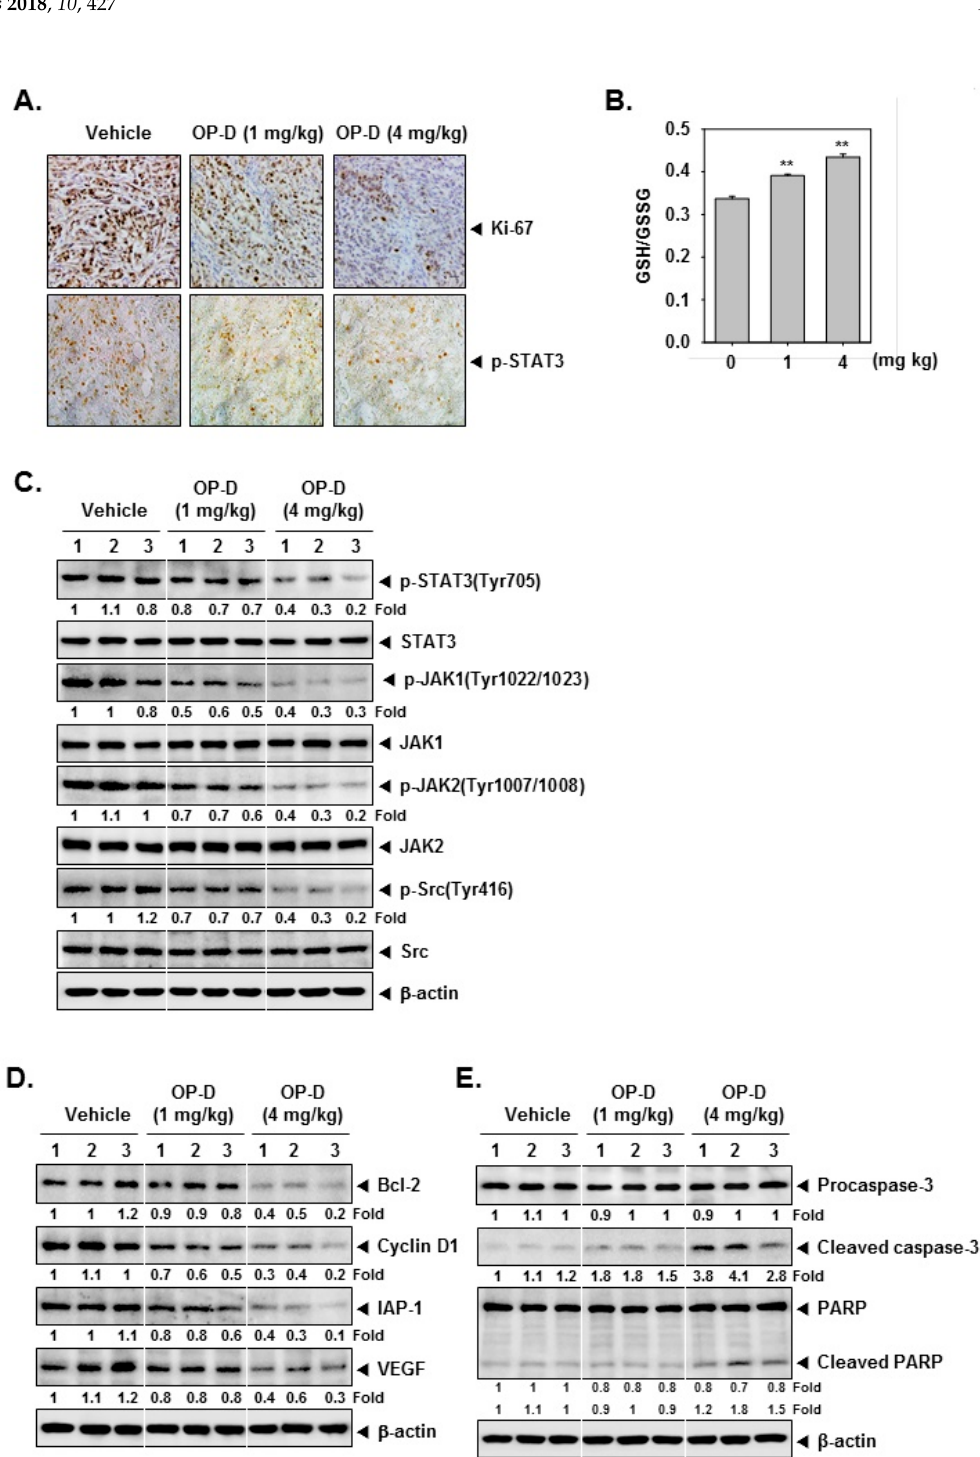
Figure 7. OP-D reduces levels of oncogenic biomarkers in NSCLC tissues. ( A ) Immunohistochemical analysis of proliferation marker Ki-67 and p-STAT3 in NSCLC tumor tissues. ( B ) GSH content in NSCLC tumor tissues treated with OP-D for 3 weeks. ( C – E ) Western blot of various proteins of interest was carried out in lysate from vehicle control, and OP-D treated mice. Data represent the mean of three measurements ± S.D., ** p < 0.01.